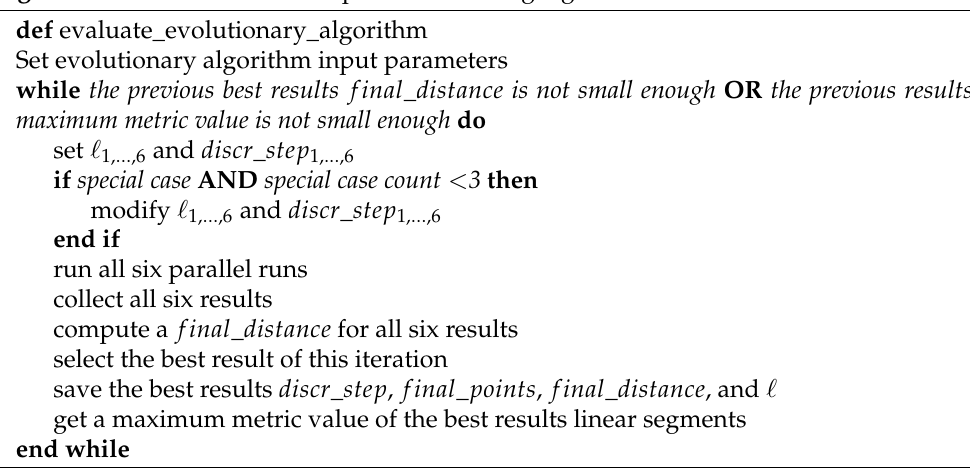
Algorithm 1 Pseudocode of the parameter tuning algorithm. def evaluate_evolutionary_algorithm Set evolutionary algorithm input